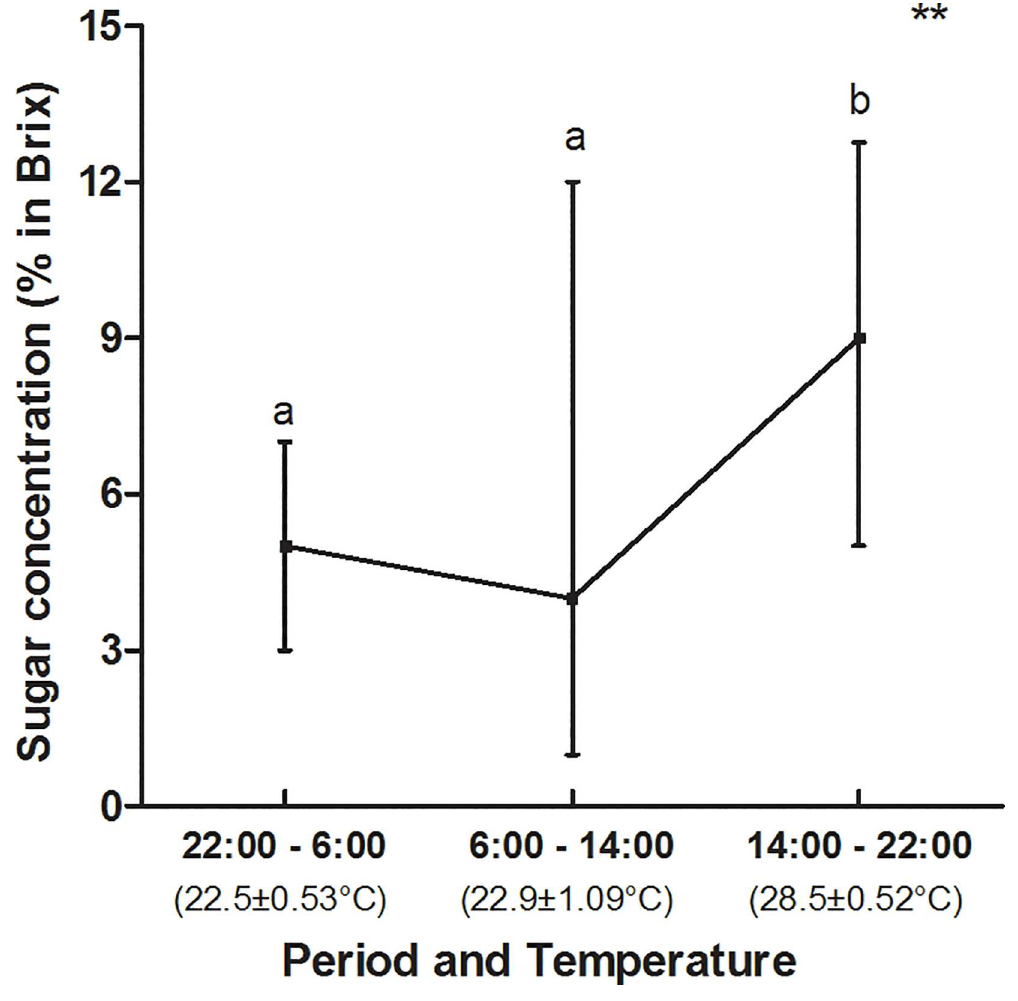
Dunn’spost-hoc. The X-axis numbersin parentheses show the mean temperature (mean ± SE) in each